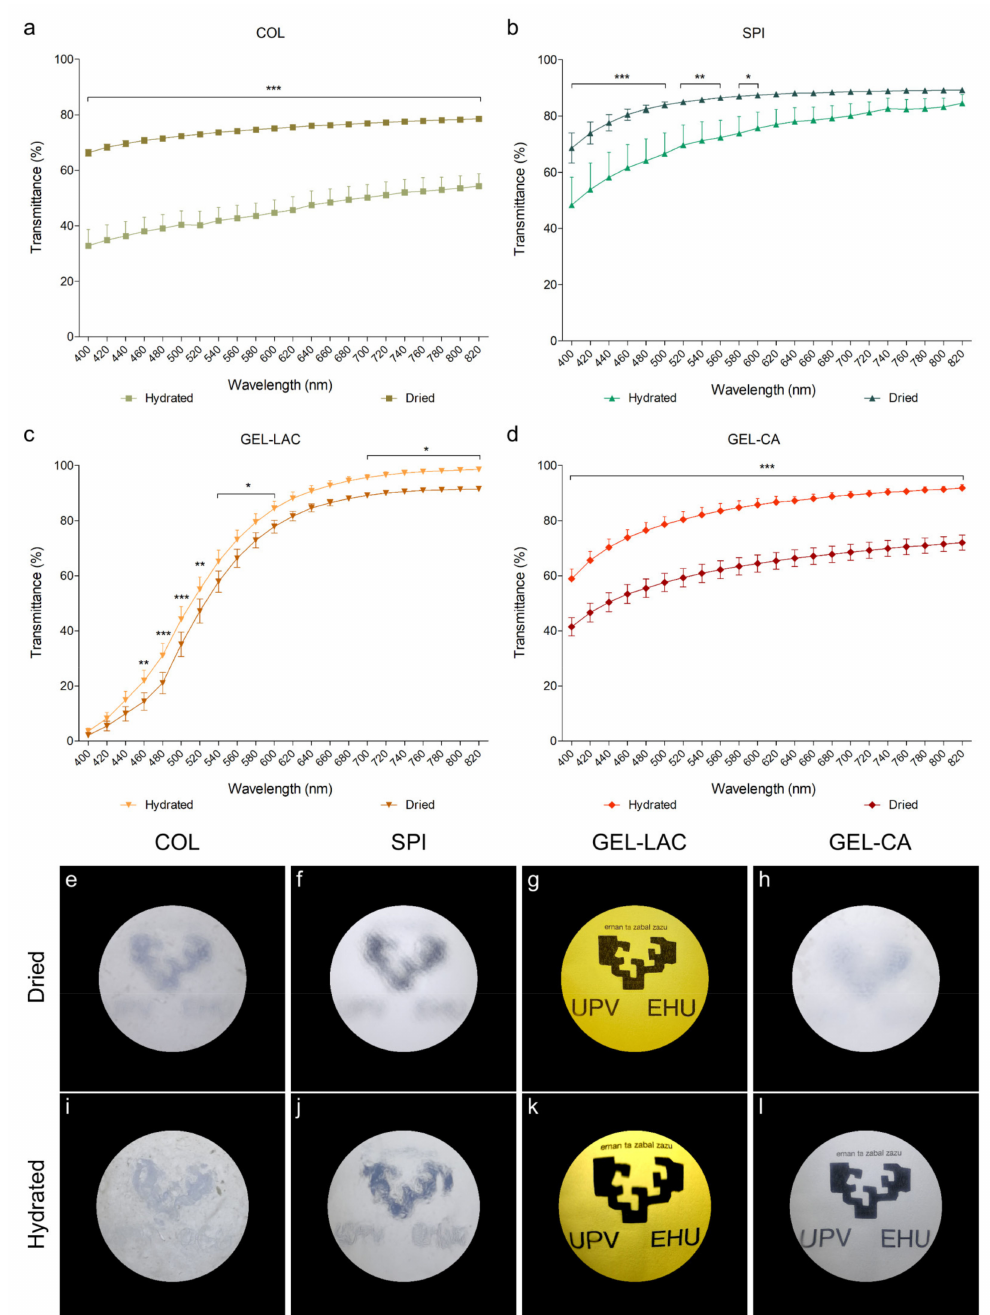
Figure 2. Light transmittance and transparency differences of dried and hydrated films. ( a – d ) Graphs show the percentage of light transmitted by each film in the visible spectrum. Data are represented as transmittance percentage mean ± SD. Statistically significant differences show differences of dried with respect to hydrated conditions of each film (* p < 0.05, ** p < 0.01, *** p < 0.001; n = 9). ( e – l ) Figures show the transparency degree of each film placed at 12 cm from a specific pattern for dried ( e – h ) and hydrated ( i – l ) films. All the images were taken of the same pattern and with the same